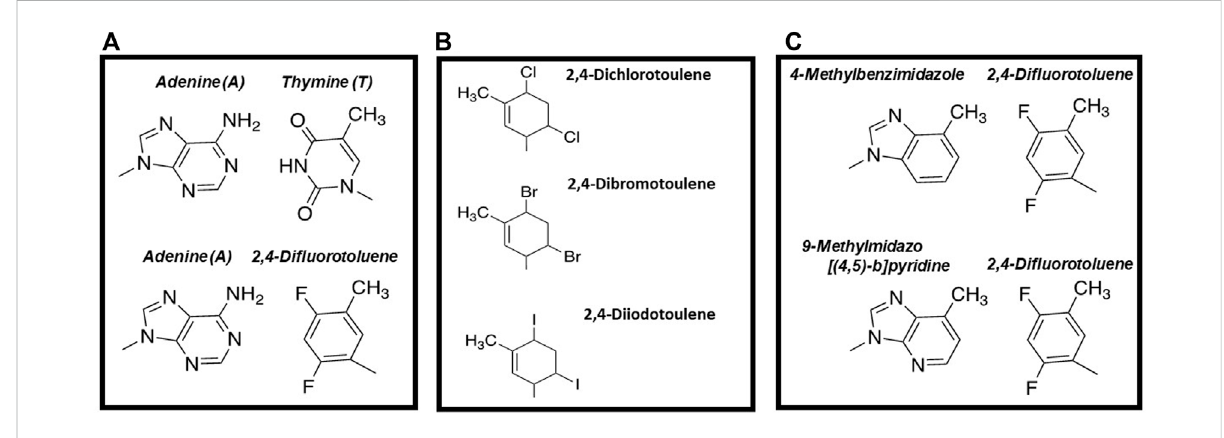
FIGURE 2 (A) Structuralcomparisonof2,4-di fl uorotoluenewiththymine (B) Structuresofthymidineanalogscontainingdifferenthalogensthatvaryinsize (C) Comparison of mixed, nucleobase-modi fi ed base pairs including adenine: 2,4-di fl uorotoluene, 4-methylbenzimidazole:di fl uorotoluene, and 9- methylimidazo [ (Kool, 2002; Kool and Sintim, 2006)-b]pyridine: 2,4-di fl